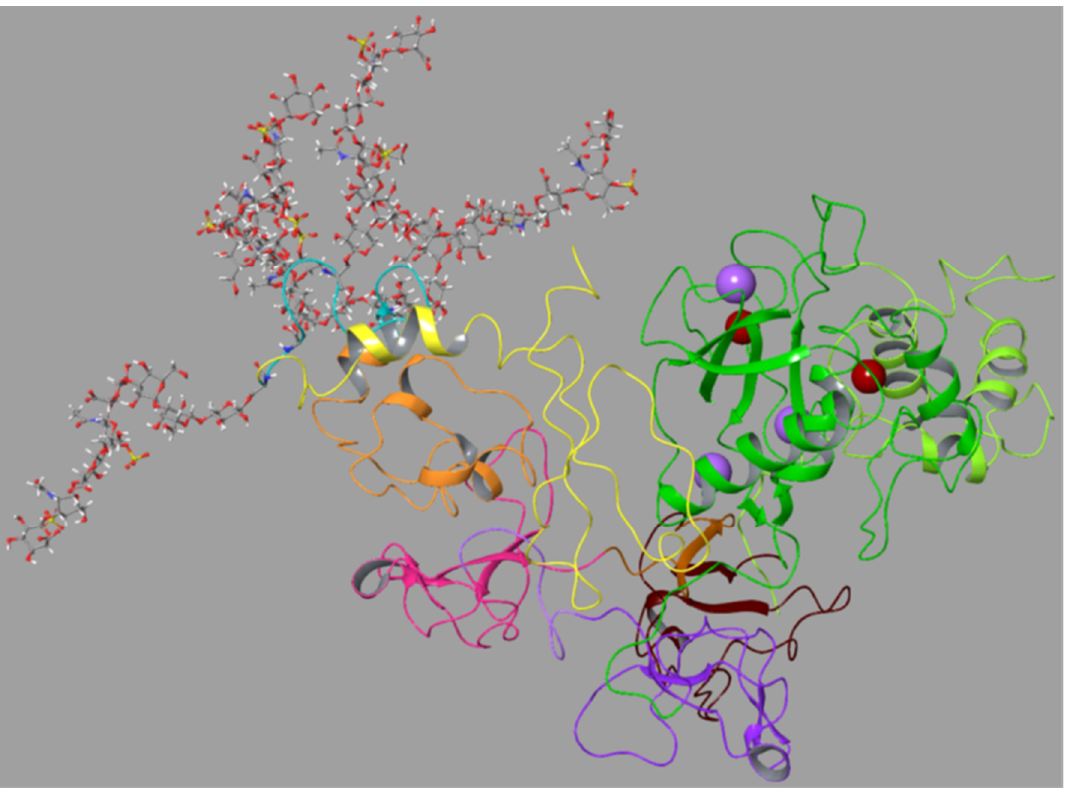
Figure 9. SG docked to the FnII module in the catalytic domain of proMMP-9. The SG core protein was docked into the FnII module of proMMP-9 using the BioLuminate program as described in the Materials and Methods. The pro- and catalytic-domain in MMP-9 are labelled in light and dark green, respectively. The FnII repeat 1 is purple; repeat 2 is pink; and repeat 3 is brown. The two zinc atoms are labelled dark red, and the three calcium atoms are labelled purple. The SG core protein is labelled as in Figure 8. The carbon atoms in the CS chains are grey, and the sulfur atoms are yellow.